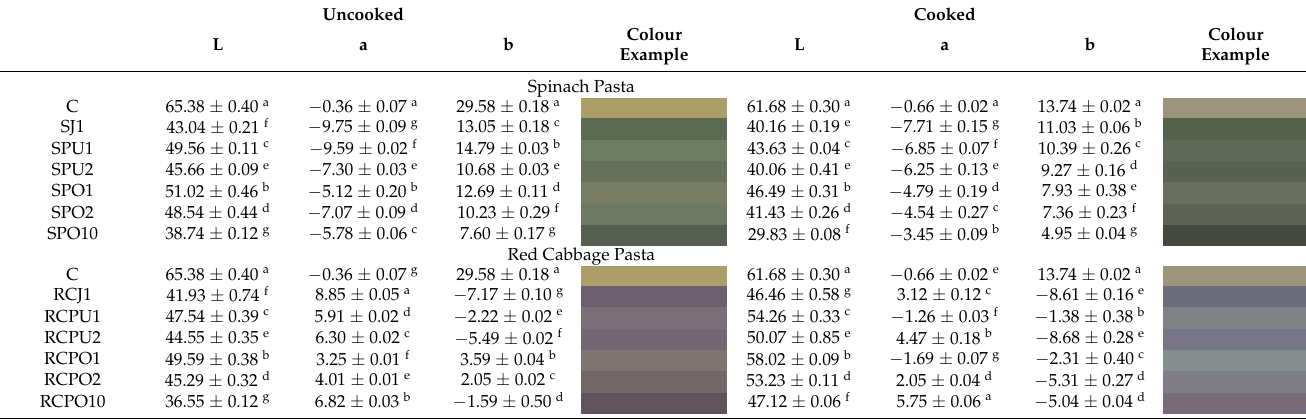
Table 4. Colour characteristics of cooked and uncooked pasta enriched with spinach and red cabbage. Uncooked Cooked L a b Colour Example L a b Colour Example Spinach Pasta